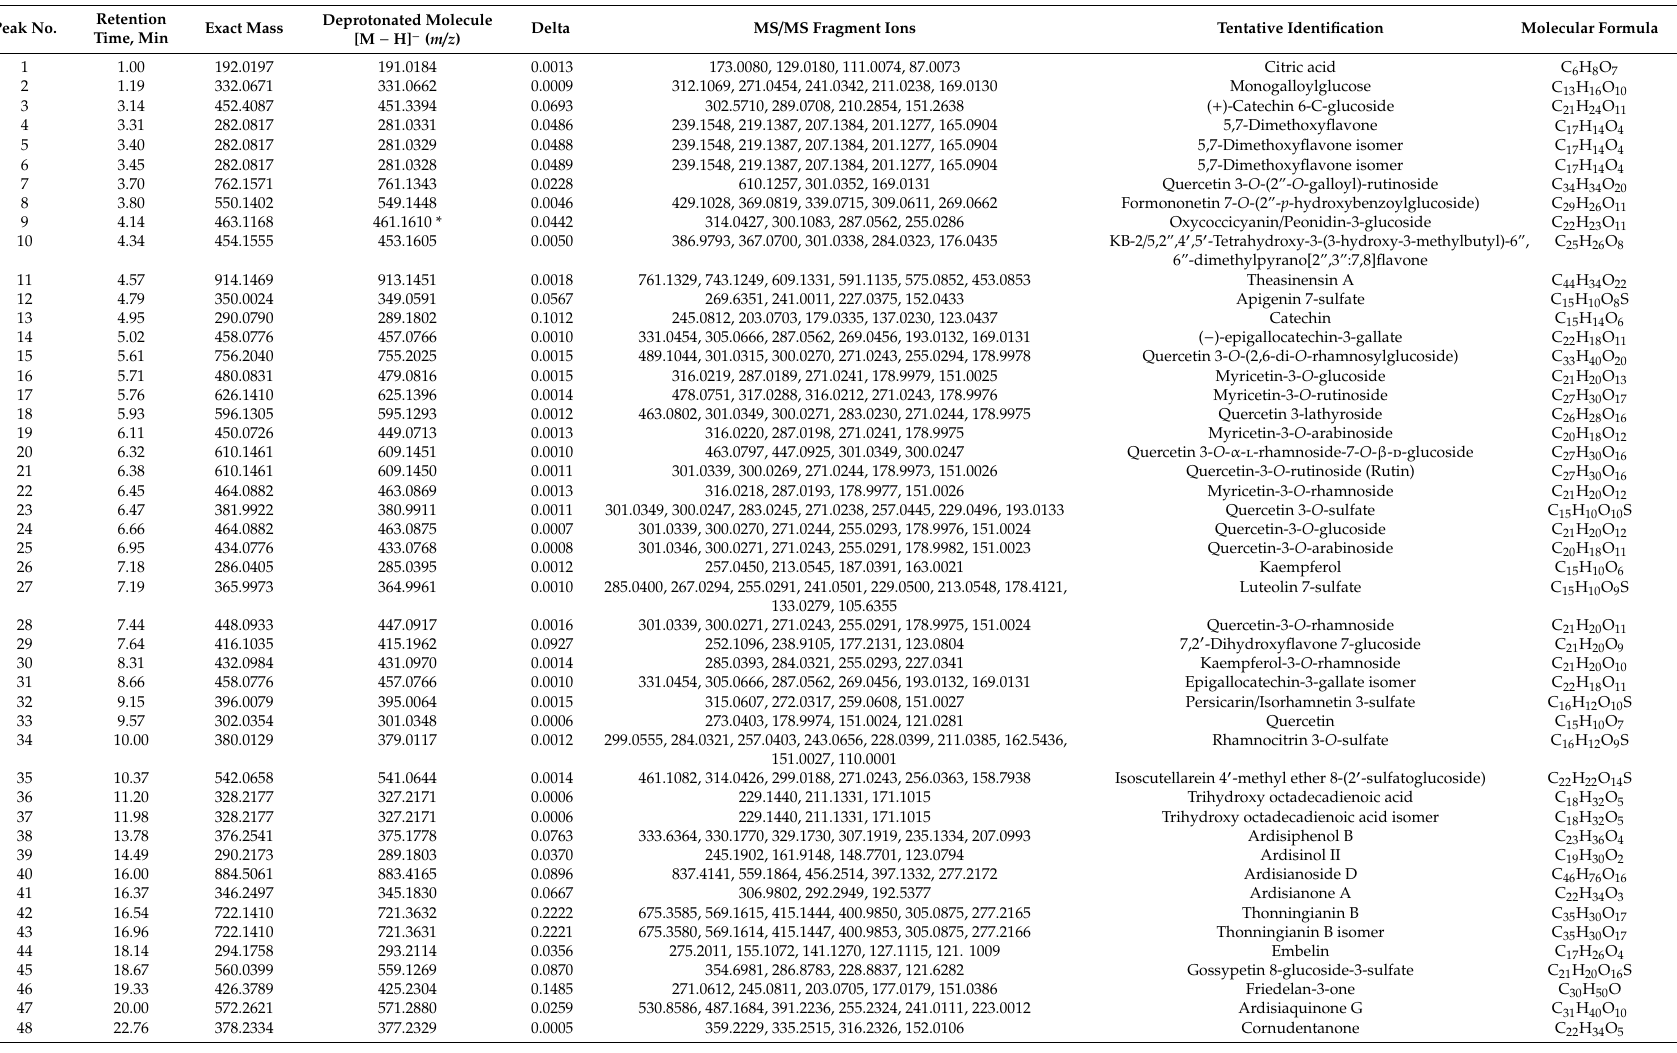
Table 2. Mass spectral characteristics and tentative identification of compounds present in 70% ethanolic leaves extract of A. elliptica . Peak